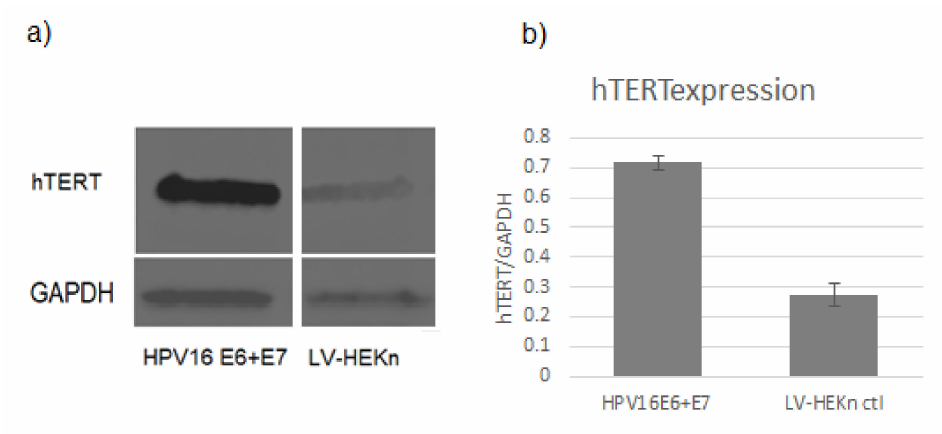
Figure 1. ( a ) Western blot experiments showed that hTERT levels were elevated in cells transduced with HPV16 E6 and E7 lentiviruses, compared to control cells (LV-HEKn). ( b ) Bar charts indicate the average level of hTERT normalized to GAPDH for three replicates of each cell